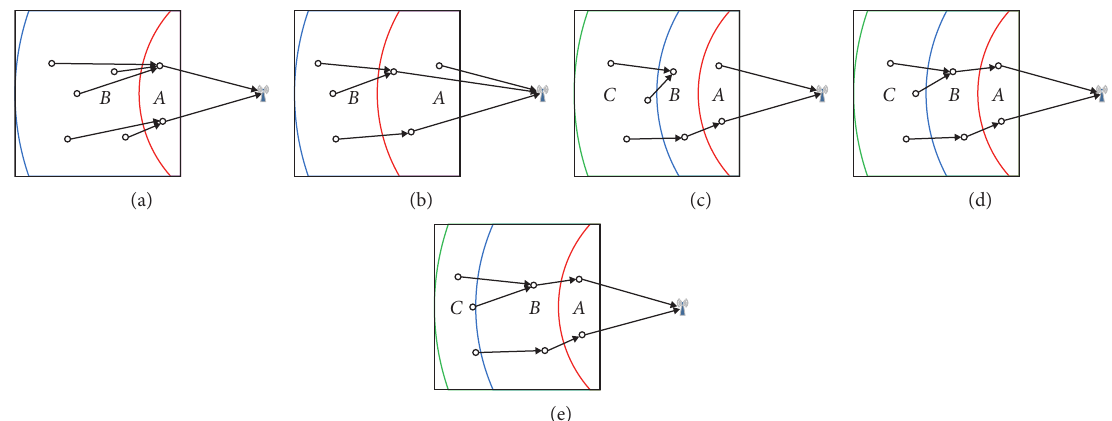
Figure 5: Partitioning scheme. (a) Partitioning scheme 1: S